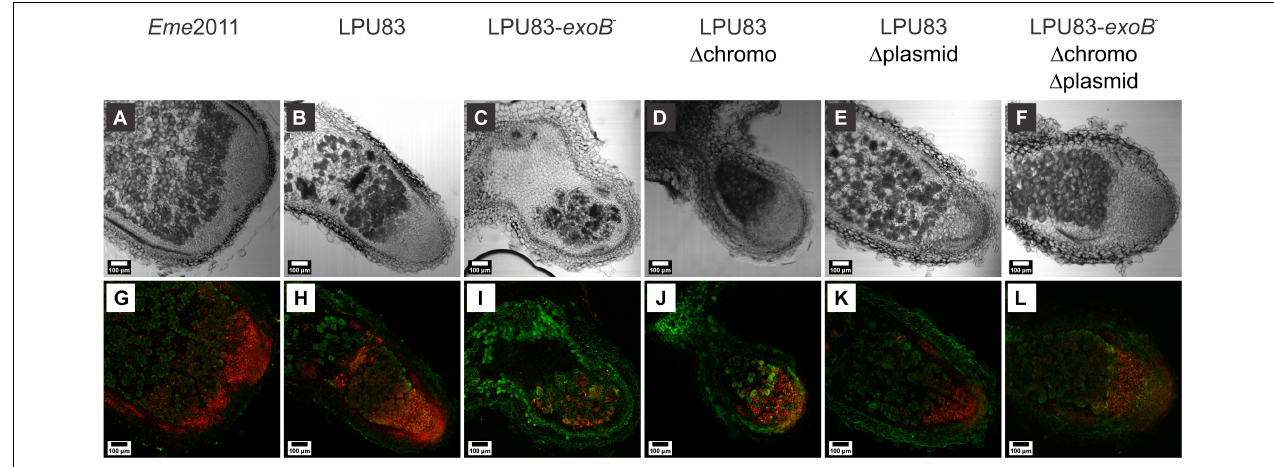
FIGURE 6 | Morphology and occupancy of M. sativa nodules generated by EPS-I mutants of LPU83. Plants infected by E. meliloti 2011 and the indicated EPS I mutant strains of R. favelukesii LPU83 were harvested at 4 weeks post-inoculation. Nodule sections of 60 µ m were obtained by means of a vibratome, and then stained with Syto 9 (green fluorescence that indicates living cells) and Propidium Iodide (red fluorescence that indicates cells with a damage in the membrane, i.e., dead). Light (A–F) and fluorescence (G–L) micrographs of full nodule slices were acquired with a confocal microscope. The photographs are representative of nodules of different plants